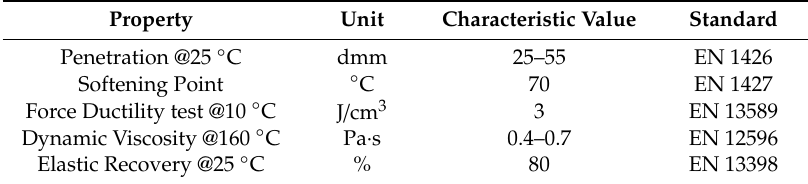
Table 1. Conventional properties of the original